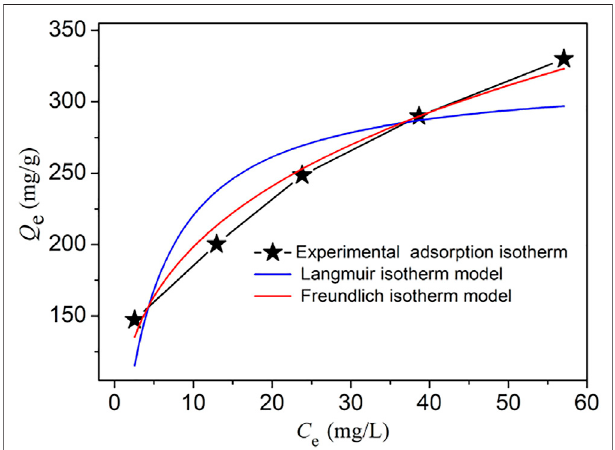
FIGURE 4 | Experimental iodine adsorption isotherms (black line) and the corresponding fi tting lines of Langmuir (blue line) and Freundlich (red line) isotherm models.